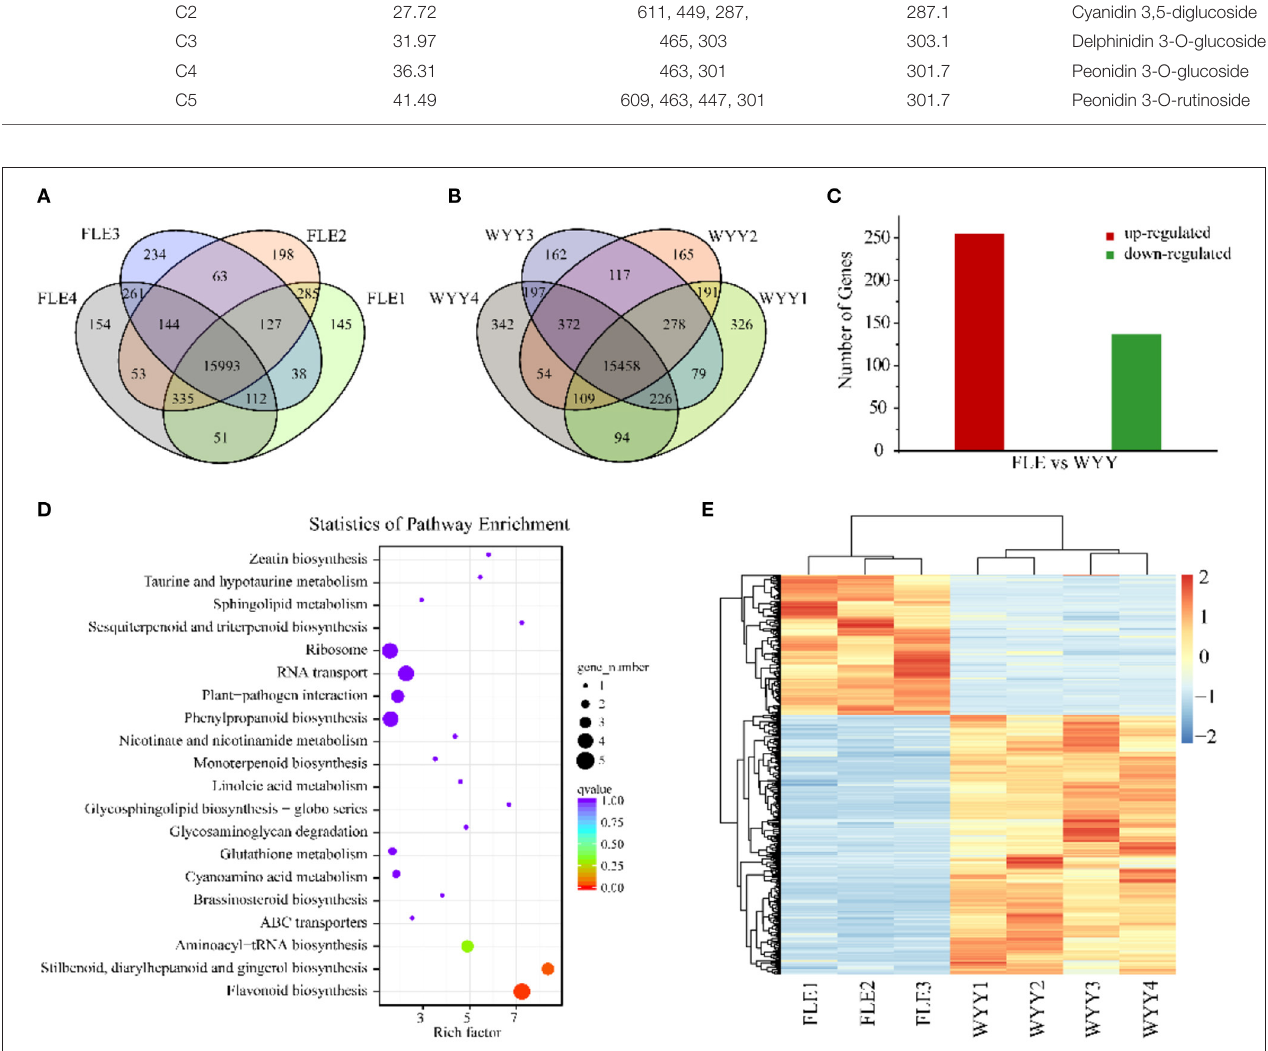
FIGURE 3 | Transcriptome profiles of WYY and FLE. (A) Venn diagram depicting the shared and specific unigenes among the four replicates of the FLE group. (B) Venn diagram depicting the shared and specific unigenes among the four replicates of WYY group. (C) The number of up-regulated and down-regulated genes. (D) KEGG functional analysis of DEGs. The X-axis represents the enrichment factor. The Y-axis represents the pathway. The color indicates the q -value (high: red, low: blue). A lower q -value indicates a more significant enrichment. Point size indicates the DEG number (the larger dots refer to a larger amount). (E) Hierarchical clustering of DEGs